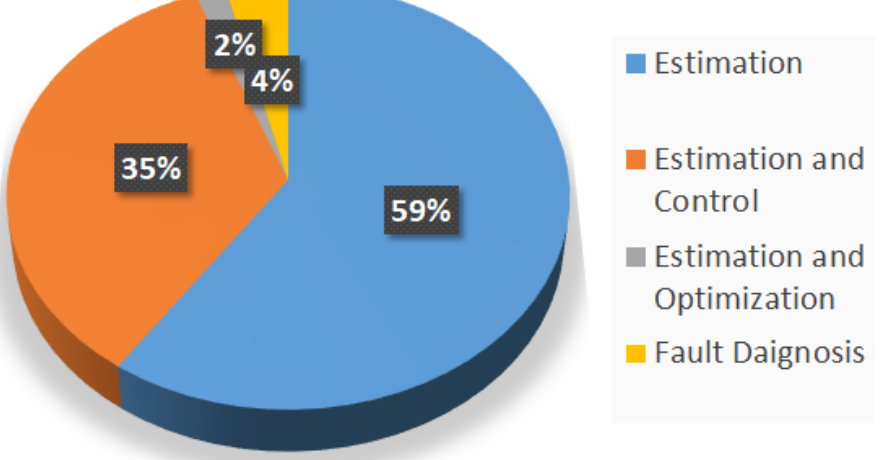
Figure 5. Percentage in terms of types of